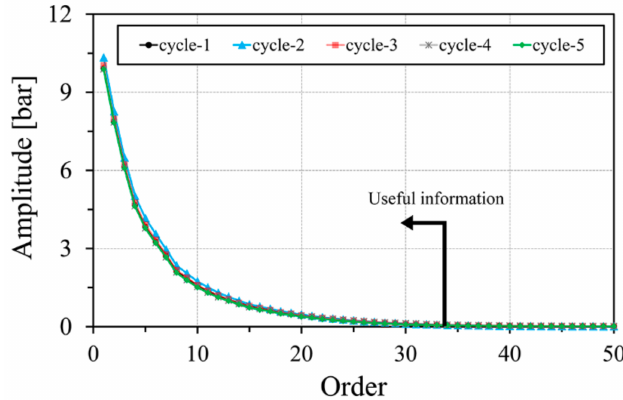
Figure 5. FFT spectrum of the pressure sensor signal of different cycles at the same operating condition (4500 rpm at full